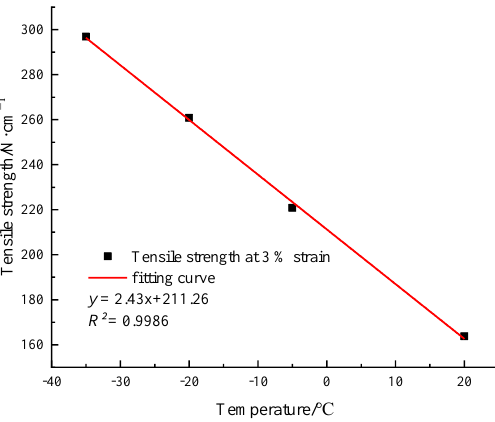
Figure 5. The tensile strength – temperature curve of HDPE specimen.